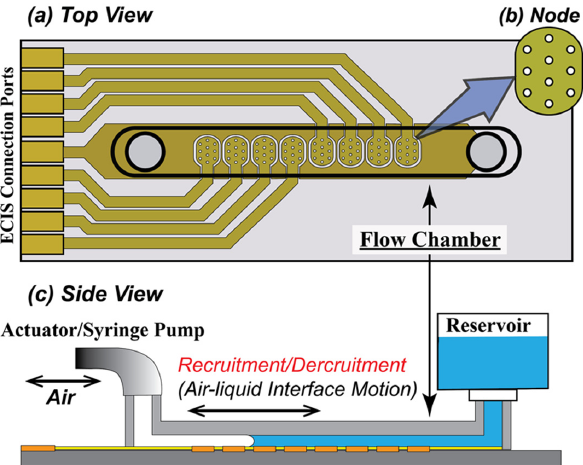
Figure 2. Schematic of ( a ) the ECIS Flow Device, ( b ) Node with 10 electrodes, and ( c ) setup of the cell culture system and the RD experiment. ( a ) The ECIS flow device has a single straight channel with length × width × depth = 50 mm × 5 mm × 0.36 mm. ( b ) Node 1 to 8 (left to right) are placed along the axial direction, covering approximately 70% of the bottom where the H441 cell layer is cultured. Each node has 10 electrodes, having a 250 µm diameter. ( c ) Growth media fills the channel from the reservoir during the culturing of a confluent monolayer that covers the electrodes. Recruit- ment is induced by a penetrating finger of air that is driven by a computer-controlled actuator pump. A reverse motion reintroduces liquid to complete one RD cycle. The device is tilted at a 45° angle to avoid bubble break-up during the RD motion.